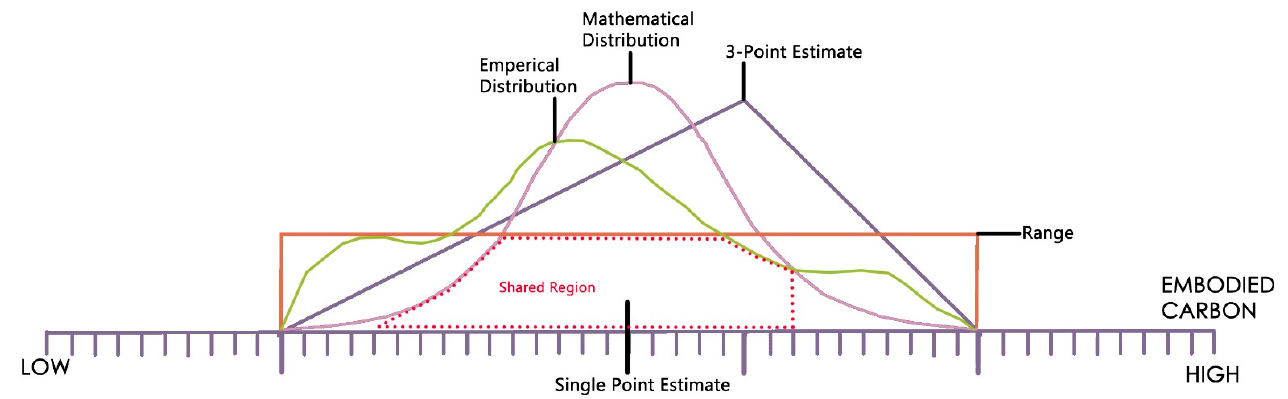
Figure 4. Graphical representation of uncertain variables. (adapted from [46]).